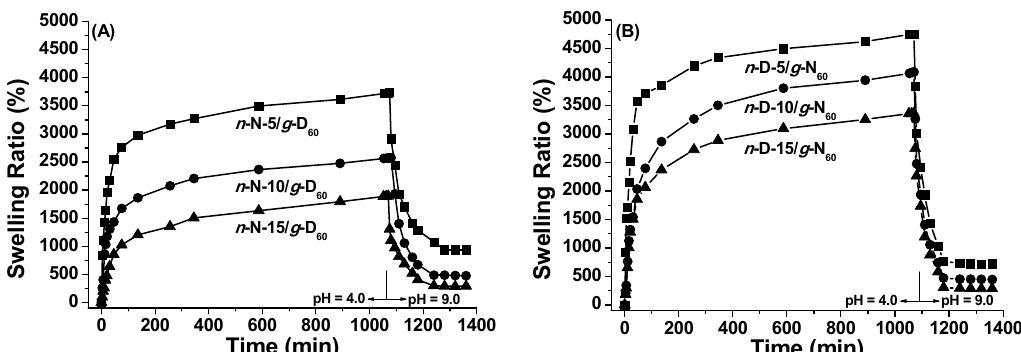
Figure 6. Swelling-deswelling kinetics of n -N/ g -D 60 ( A ) and n -D/ g -N 60 ( B ) hydrogels in deionized water at pH = 4.0 and 9.0 (20 °C).